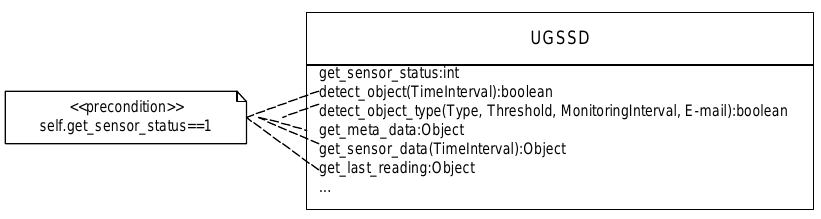
Figure 4. Example Web services for the